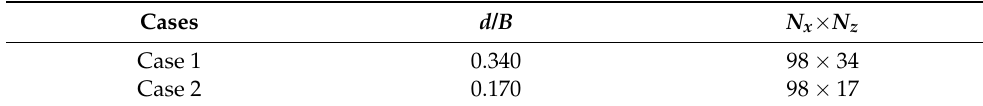
Table 2. Numerical parameters in SPH